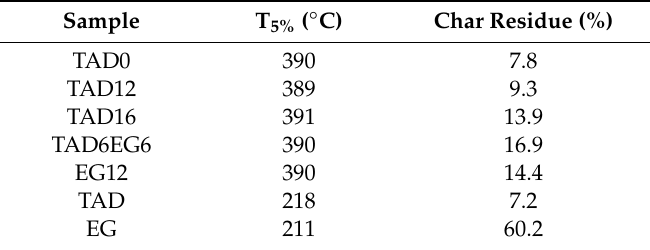
Figure 3. TGA curves of TAD0, TAD12, TAD16, TAD6EG6, EG12, TAD and EG under a nitrogen atmosphere. Table 3. Thermal parameters of PBT / PET blend and flame-retardant PBT / PET